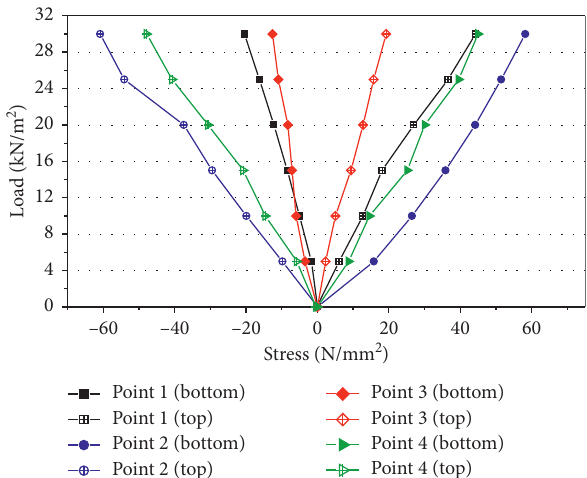
Figure 14: Load-stress curves of the three-span continuous formwork specimens.